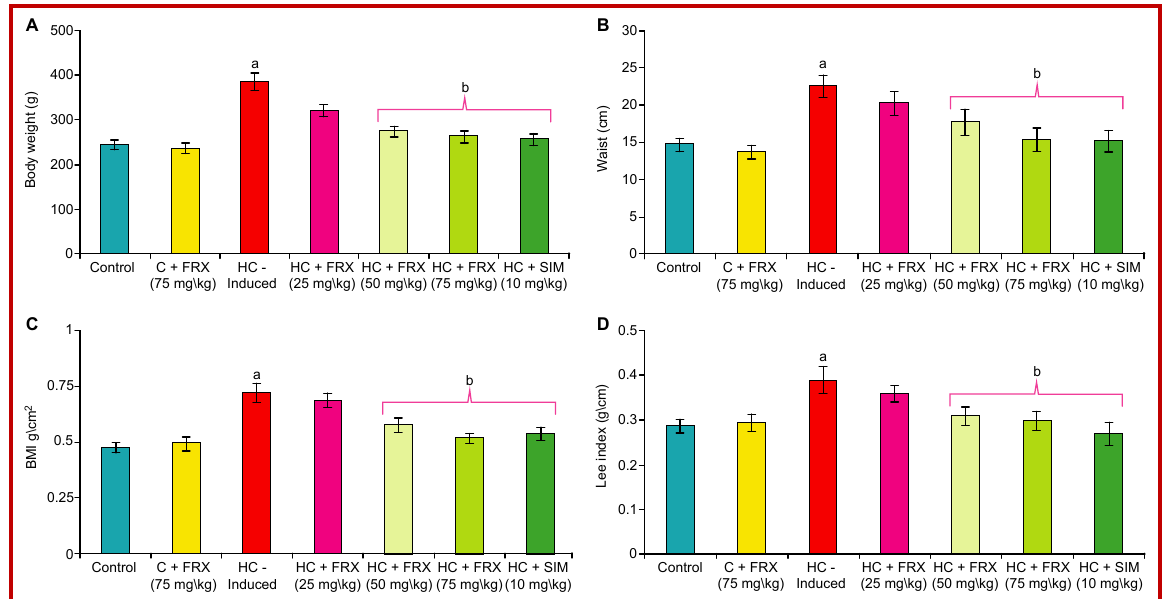
Figure 1: Effect of different concentrations of fraxetin treatment on (A) Body weight (B) waist, (C) BMI and (D) Lee index. Values